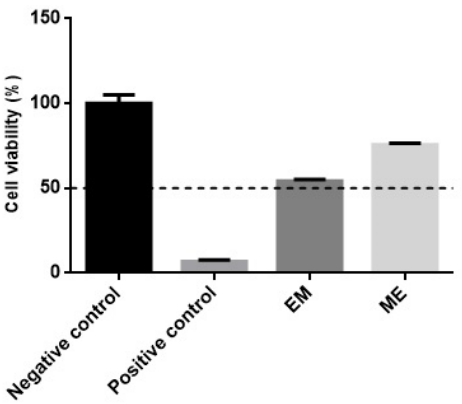
Figure 7. RHE irritability test of conventional emulsion (EM) and microemulsion (ME) compared to saline 0.9 % and sodium dodecyl sulfate solution at 5 % m / v (used as negative and positive controls, respectively). The dotted line delimits the minimum viability level for a potentially irritating sample. The data represent the means of three determinations ± standard deviation.